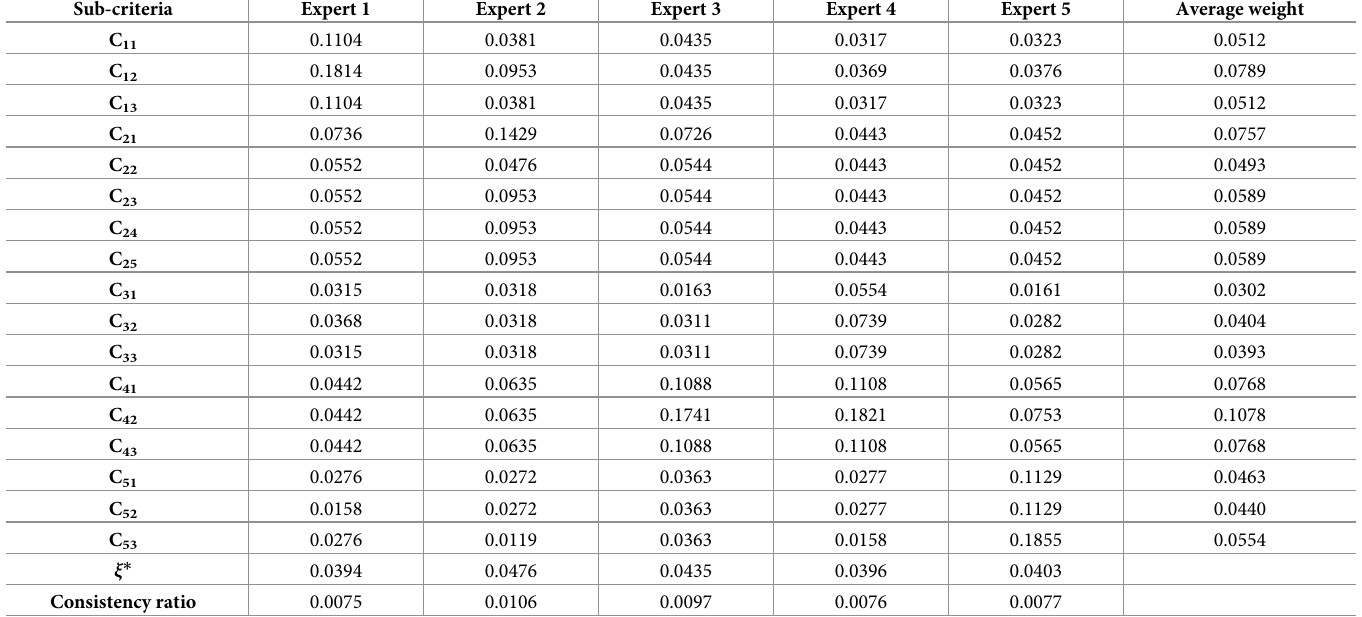
Table 7. Subjective weights and consistency